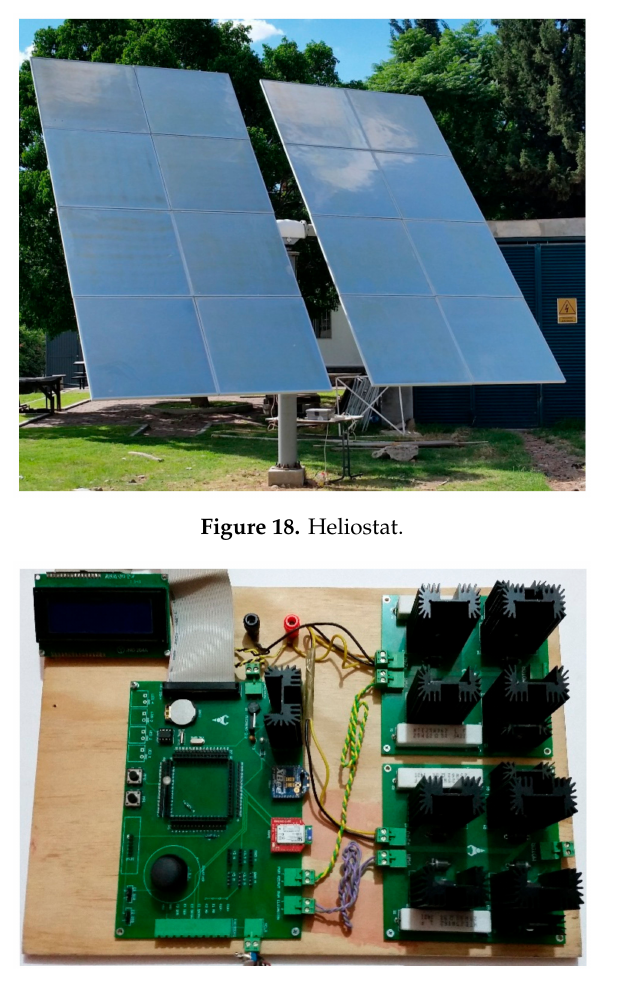
Figure 19. Remote terminal unit.